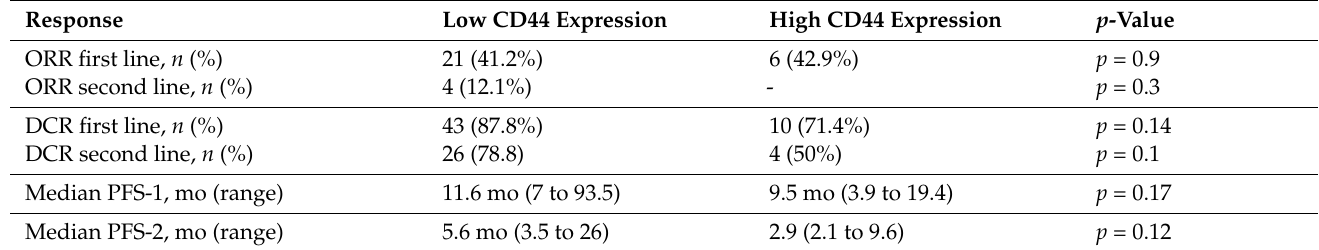
Table 3. Response to first and second line. Abbreviations: ORR = overall response rate; DCR = disease control rate; CR = complete response; PR = partial response; SD = stable disease; PD = progression disease; PFS-1 = progression-free survival in first line; PFS-2 = progression-free survival in second line; mo = months.